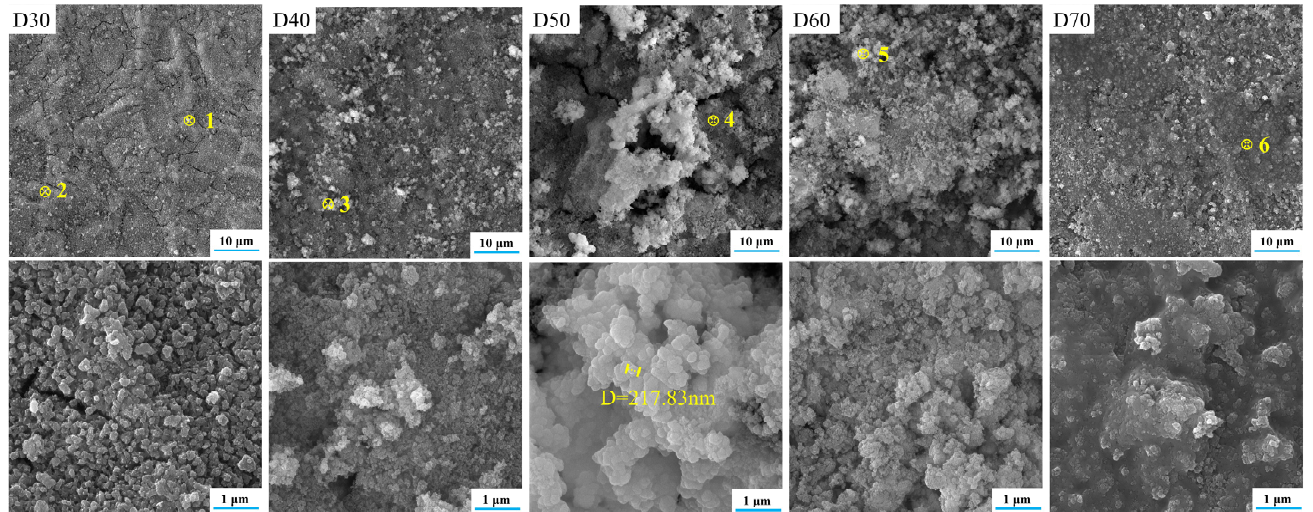
Figure 3. SEM images of the deposition products (D30 − D70).